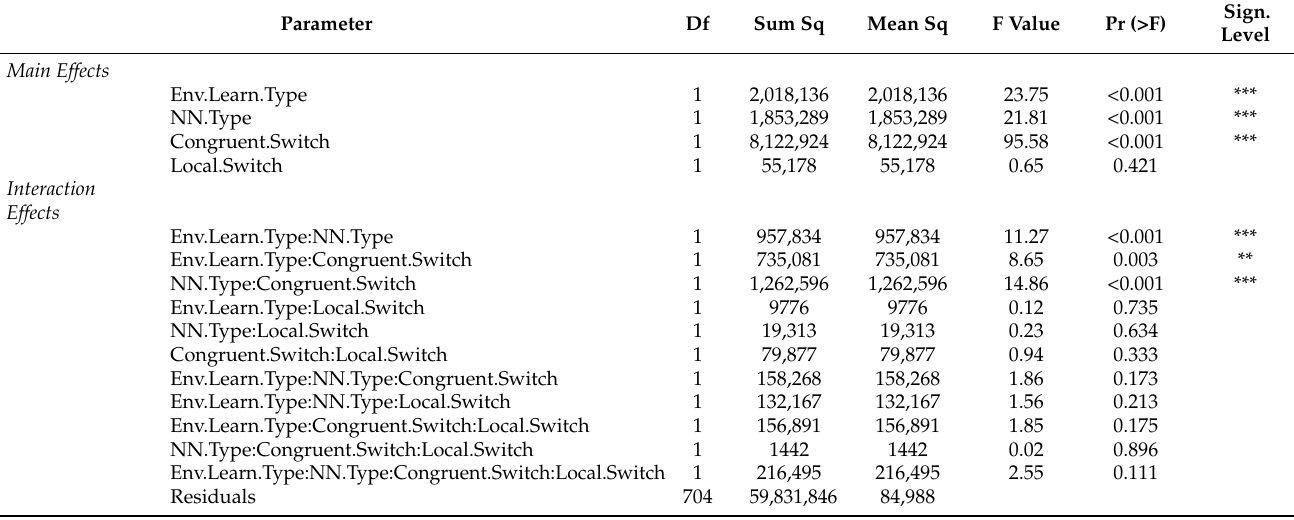
Table 4. Parameter Effects ANOVA—Converge Step. Asterisks denote significance level (*** <0.001, ** <0.01).